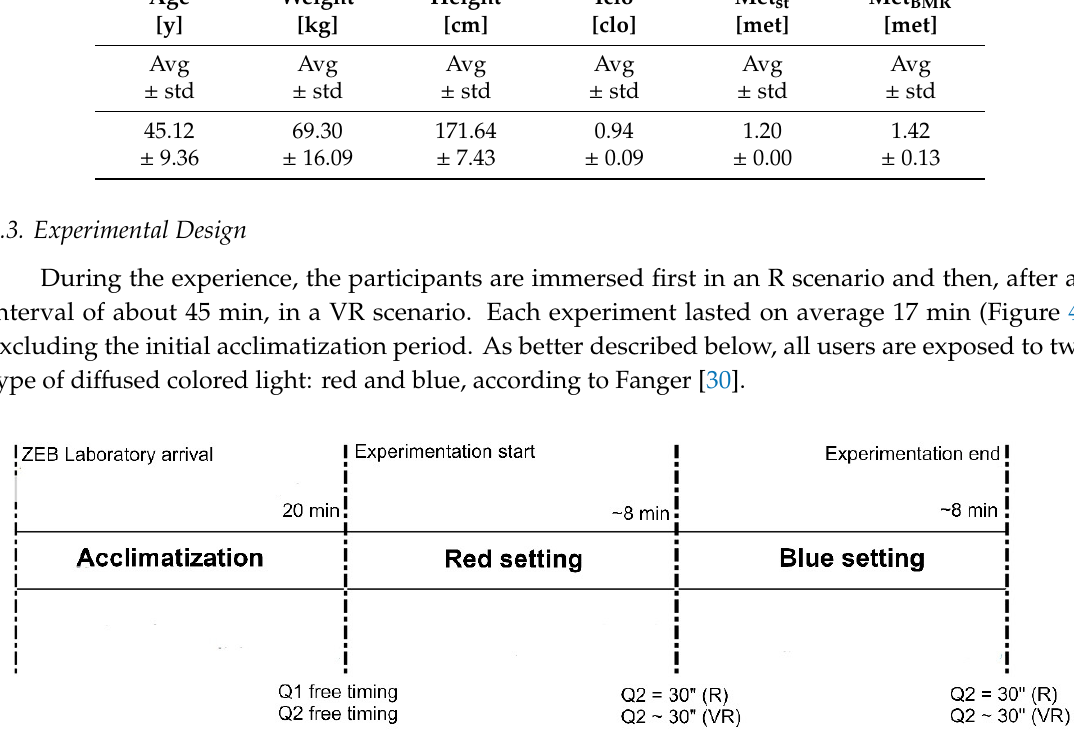
Table 3. Aggregated data of the 25 participants involved in the test.